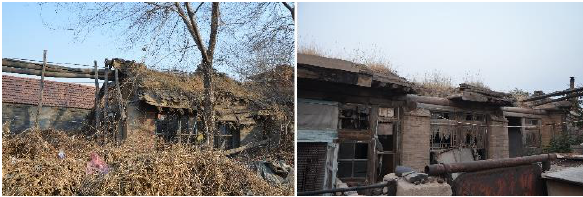
Figure 4. Traditional houses left in decay Left: Ancient town in Kaiyuan; right: ancient town in Xiongyue. Photo by Li Bing, 2016.